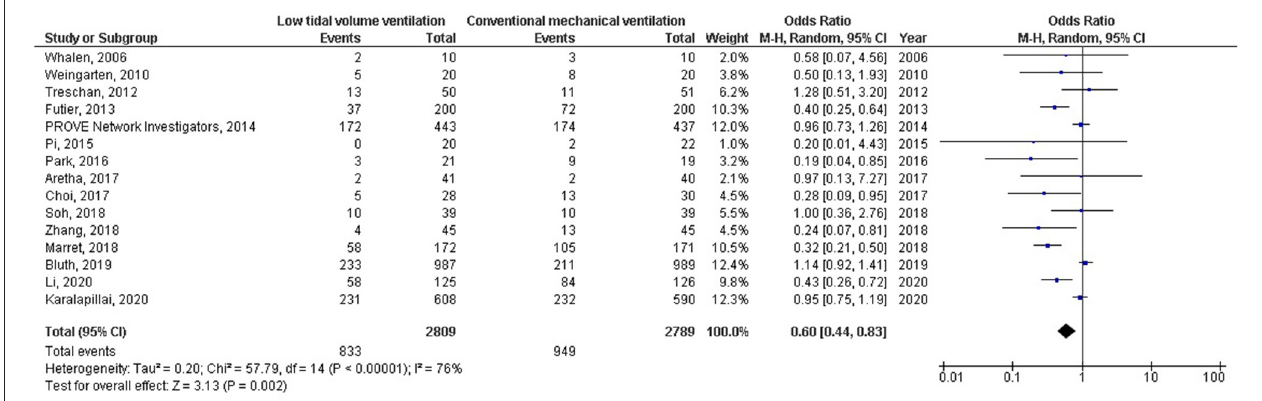
FIGURE 2 | Forest plot of the low tidal volumes strategy vs. conventional mechanical ventilation in subjects undergoing surgery on postoperative pulmonary complications.